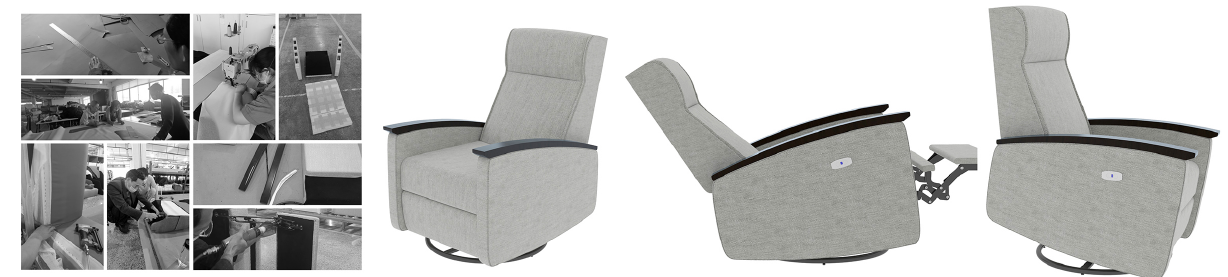
Figure 13. Smart sofa prototype development. Commissioned factory prototype development and installation of the motor to adjust the seat angle and